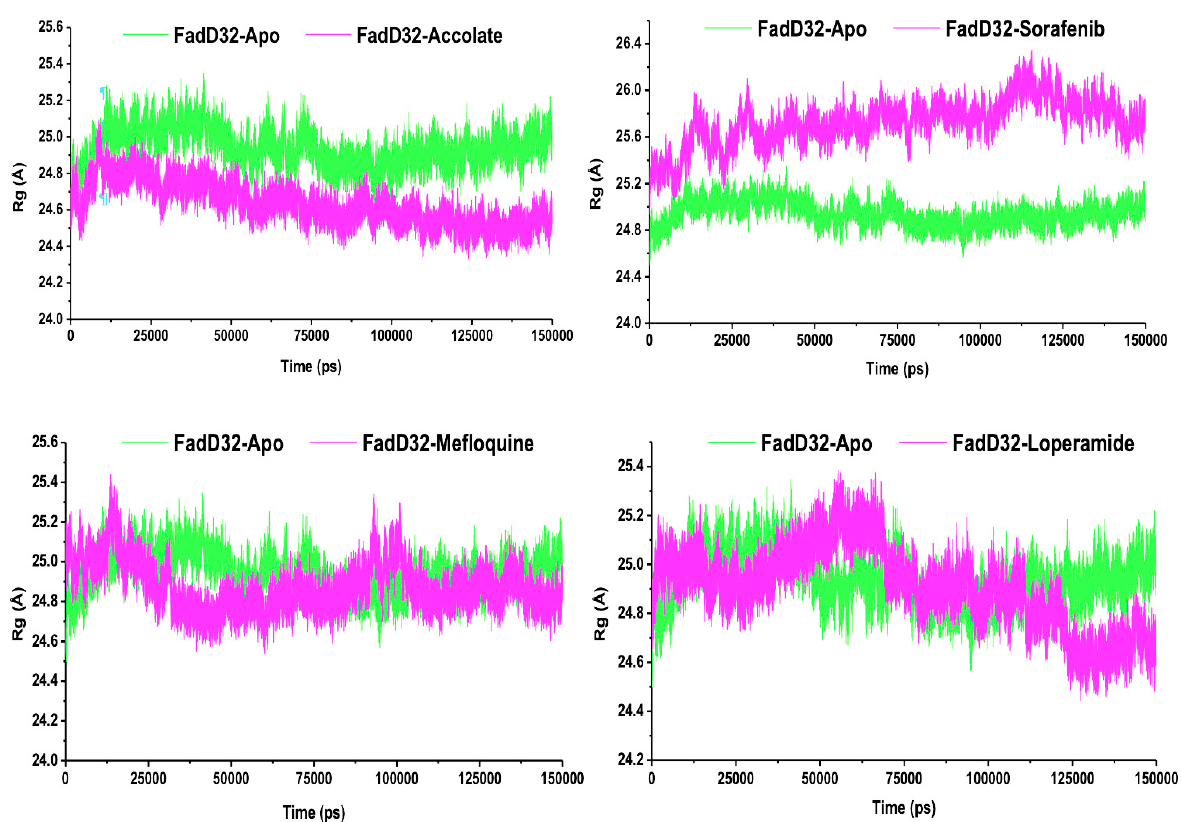
Figure 7. Radius of gyration plot of the FadD32-Apo, FadD32-Accolate, FadD32-Sorafenib, FadD32- Mefloquine, and FadD32-Loperamide.